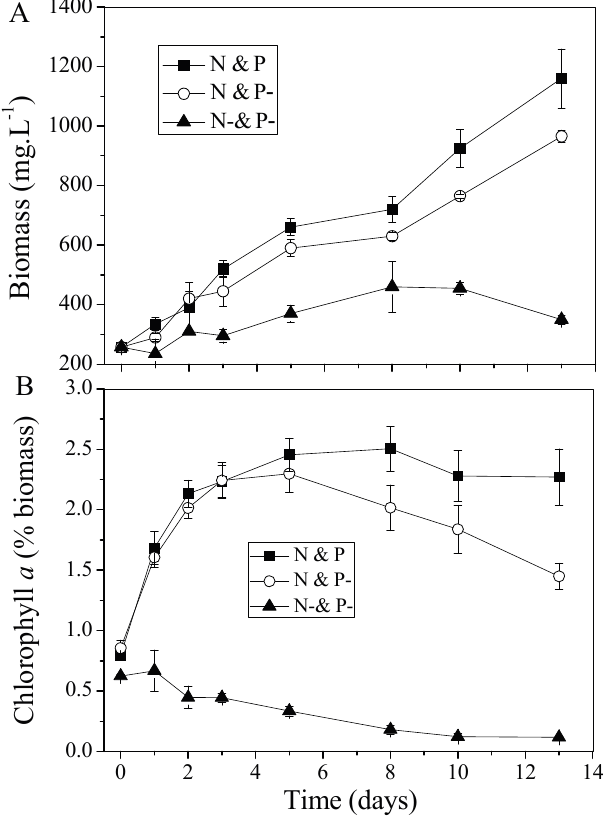
Figure 1. Profiles of ( A ) biomass growth and ( B ) chlorophyll a cont e nt of C. vulgaris in different media. Values shown are averages of two samples ±